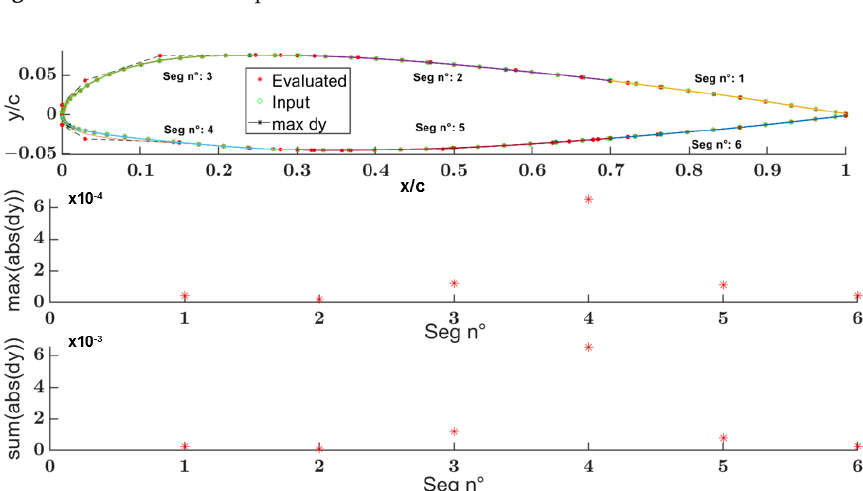
Figure 20. NACA 23012 input airfoil.